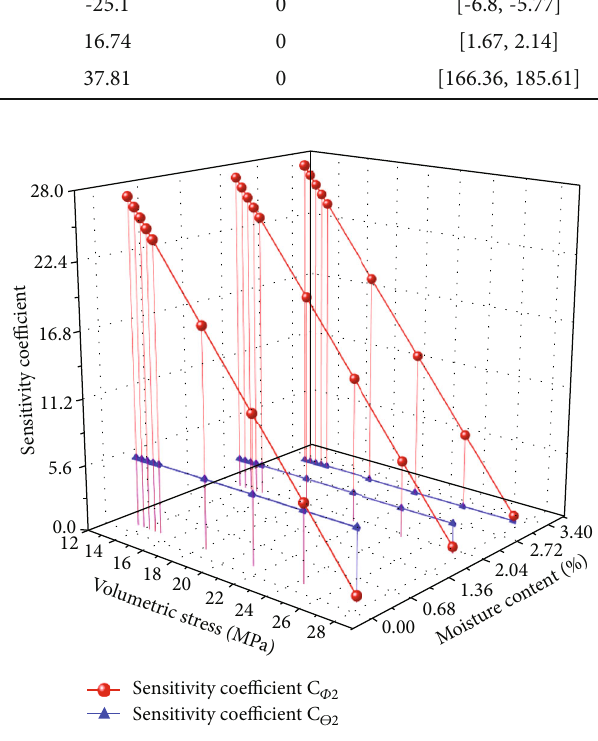
Figure 11: Calculation of sensitivity coe ffi cient of each experimental